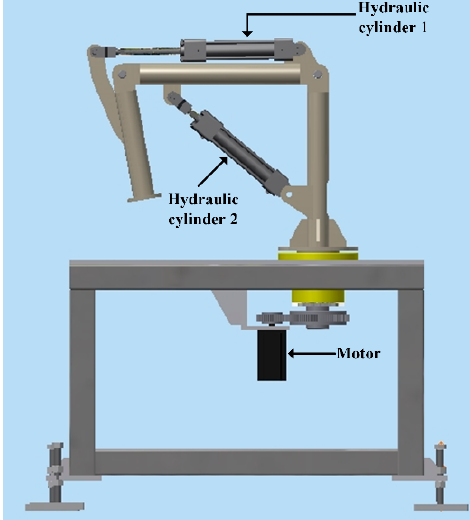
Figure 2. The 3DOF hydraulic servo system.